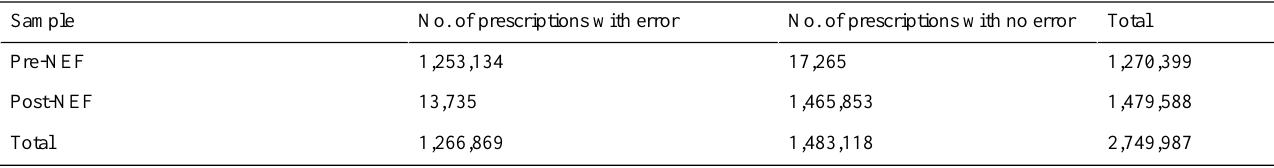
Table 9. Chi-square test of null-hypothesis with no significant improvement in interoperability errors.